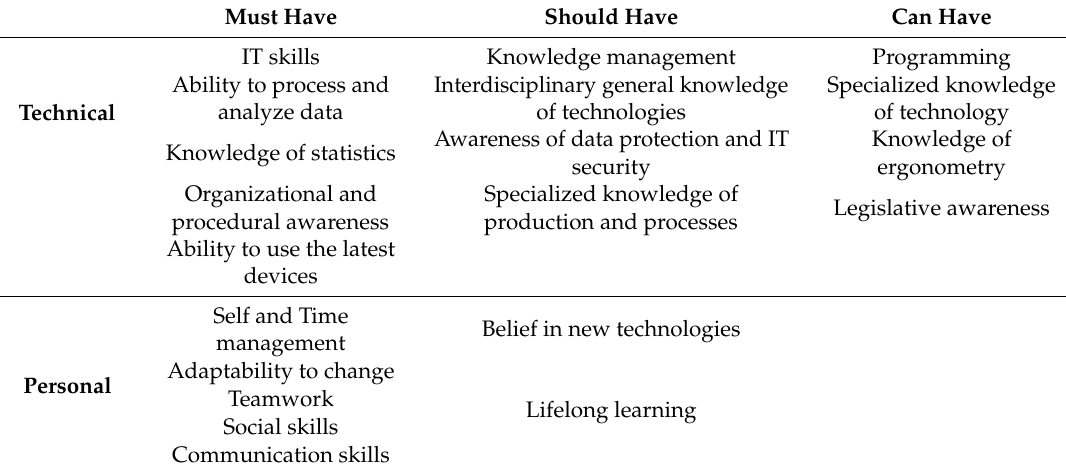
Table 1. Classification of necessary skills and abilities for Industry